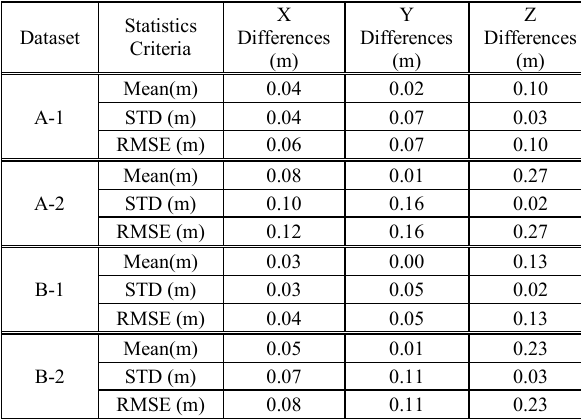
Table 2. Mean, STD, and RMSE of the differences between image-derived and RTK-GNSS coordinates of the twelve check points for the four datasets.